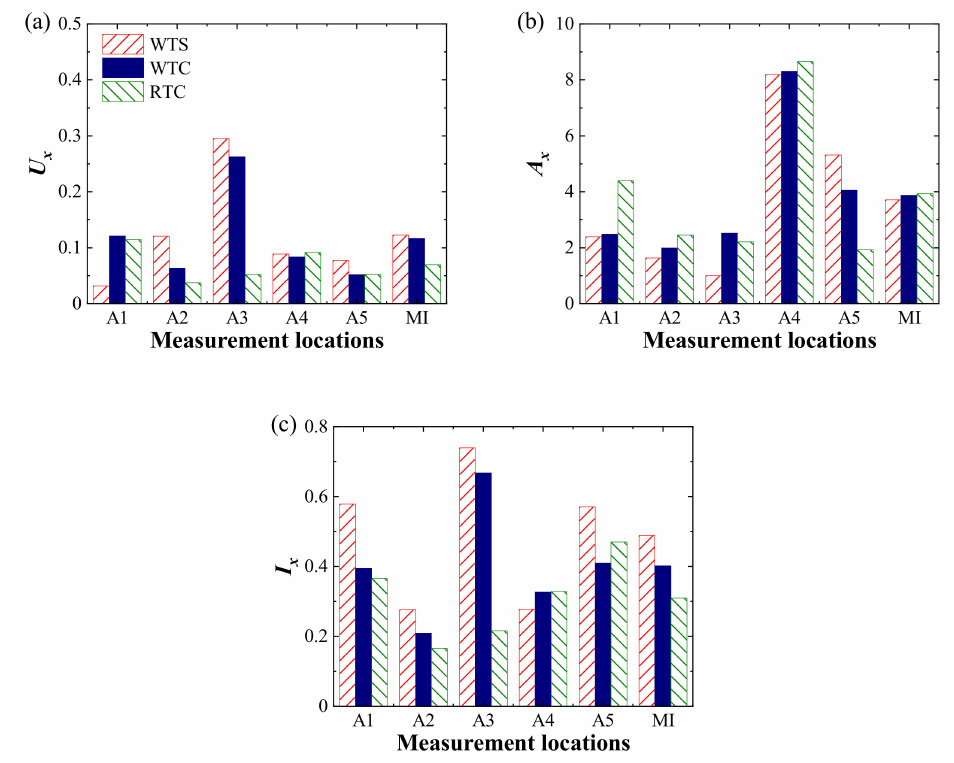
Figure 9. Special indexes at measurement locations: ( a ) mean velocity; ( b ) inclination angle; ( c ) turbu- lence